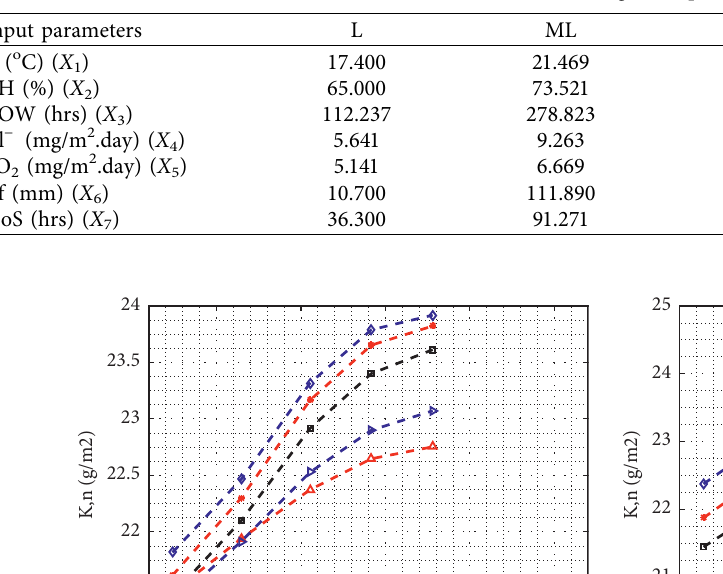
Table 6: The variation range of input parameters.